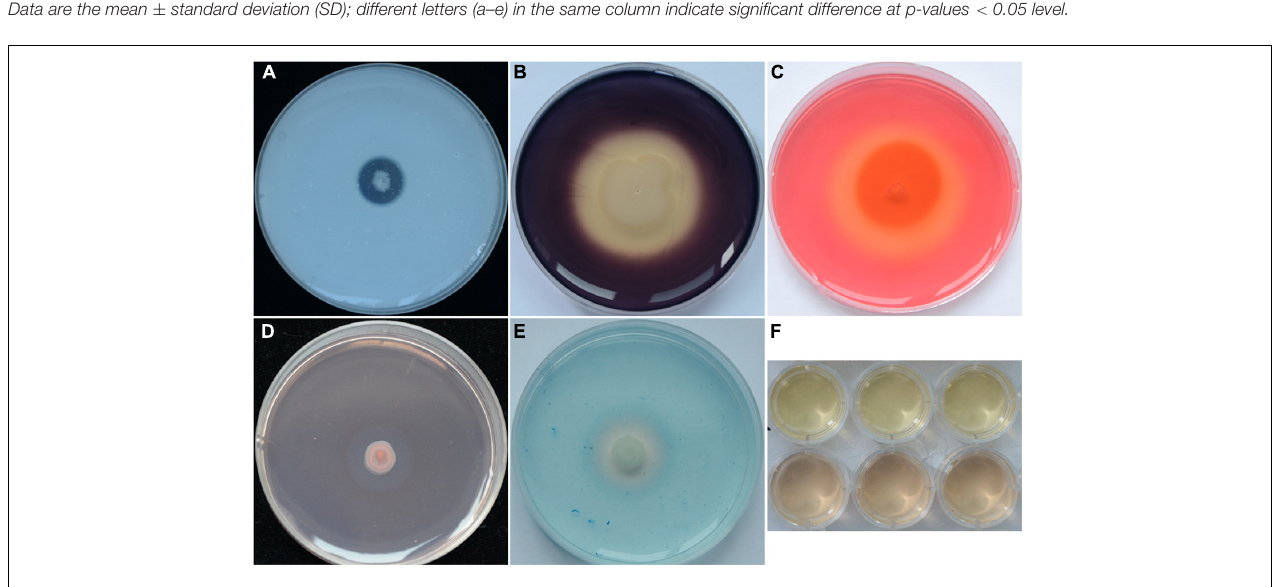
but not PPO, compared to non-treated seedlings ( Table 3 ).